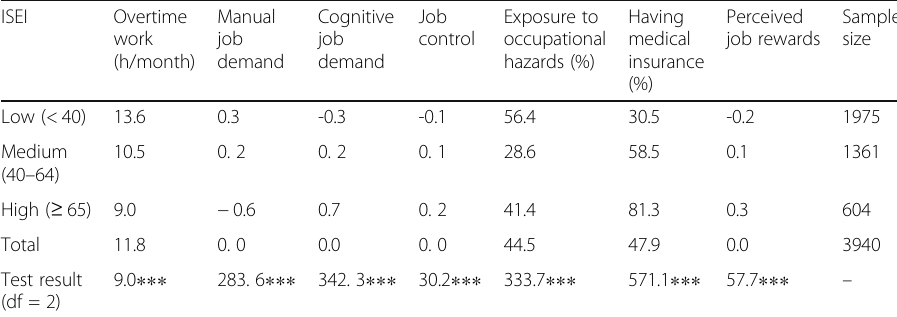
Table 3 Working conditions among different occupational status groups ISEI Overtime work